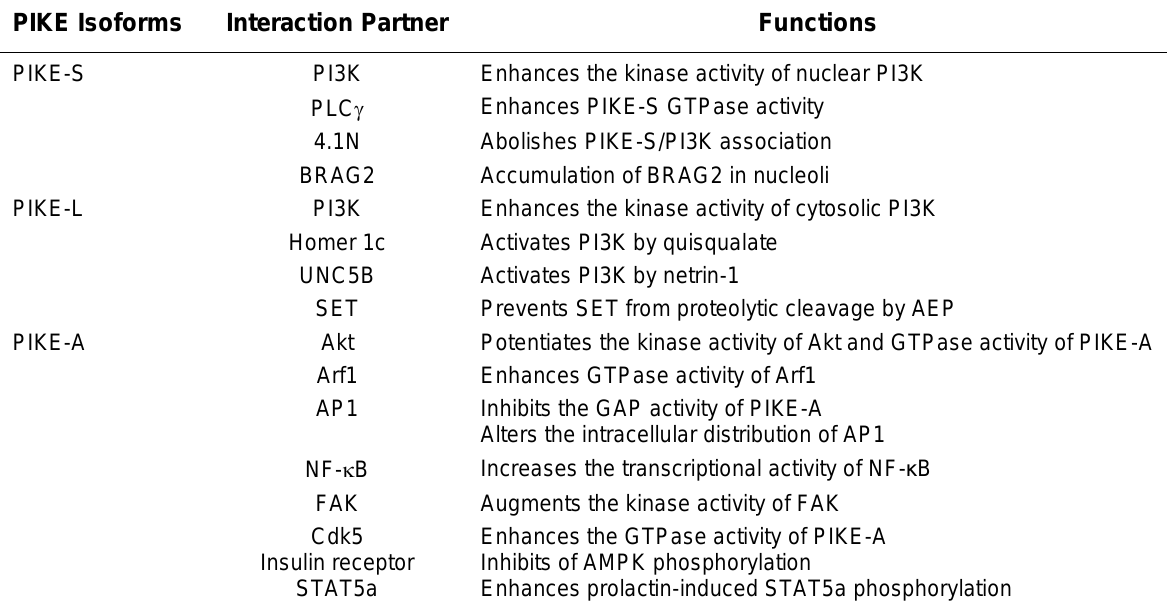
Interaction Partners of PIKE and Their Functional Consequences after Association